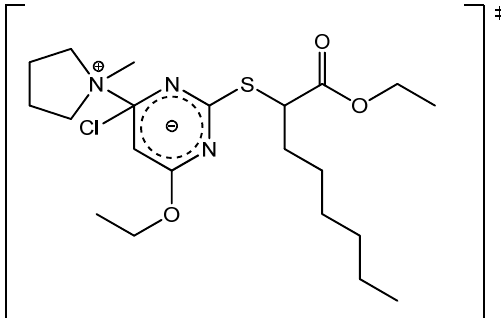
Figure 8. Chemical structures of not isolated hypothetical intermediates of the respective intermediate stages during reaction with N